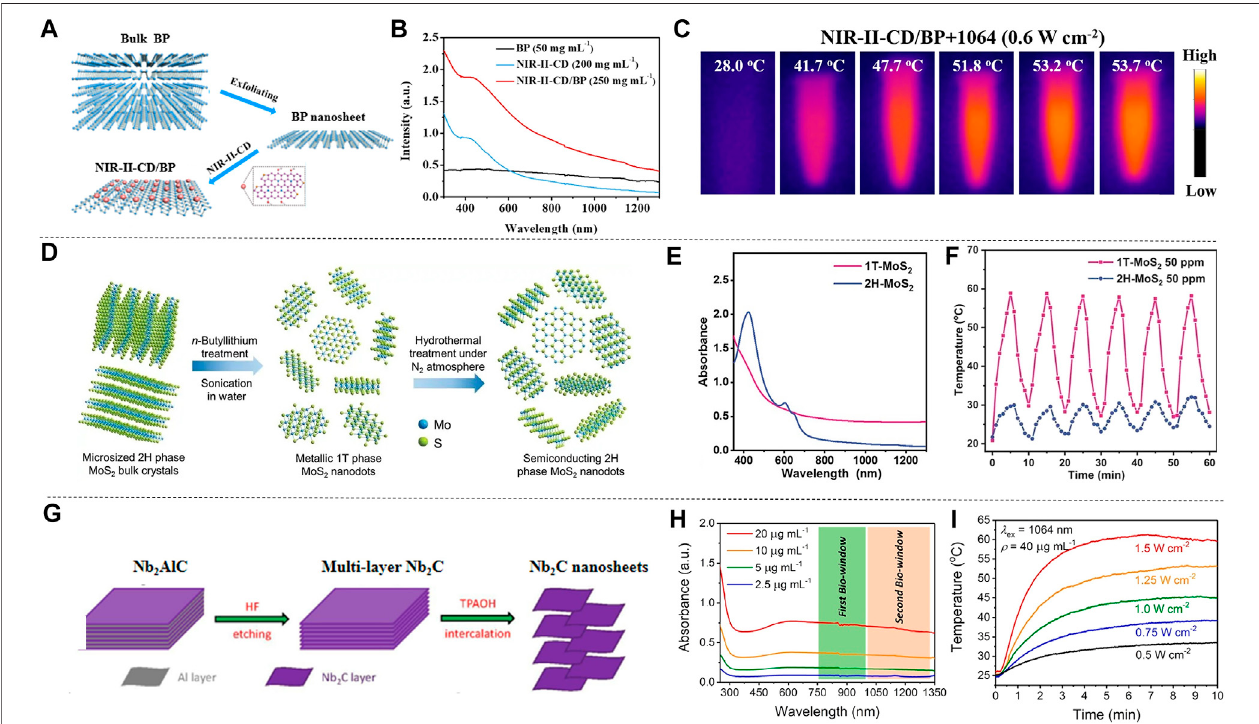
FIGURE 4 | Examples of 2D material synthesis and optical properties. (A) Synthesis process of NIR- Ⅱ -CD/BP. (B) Absorption spectra of BP NSs, NIR- Ⅱ -CD and NIR- Ⅱ -CD/BP from UV to NIR- Ⅱ regions. (C) Intuitive temperature image of NIR- Ⅱ -CD/BP solution under 1,064 nm (0.6 W cm − 2 ) irradiation (reproduced from (Geng et al., 2019) withpermissionfrom American Chemical Society). (D) Synthesis process ofultra-thin single layer 1T-MoS 2 and 2H-MoS 2 nanodots. (E) UV-vis-NIR spectra of 1T-MoS 2 and 2H-MoS 2 nanodots. (F) The temperature change of 1T-MoS 2 and 2H-MoS 2 nanodots solution after six times of laser on/off (heating/cooling) (reproduced from (Zhou et al., 2020) with permission from Wiley-VCH Verlag). (G) Preparation process of Nb 2 C NSs. (H) UV-vis-NIR absorption spectra of Nb 2 C NSs with different concentrations. (I) Temperature change of Nb 2 C NSs irradiated with different power density 1,064 nm laser (reproduced from (Lin et al., 2017) with permission from American Chemical Society).